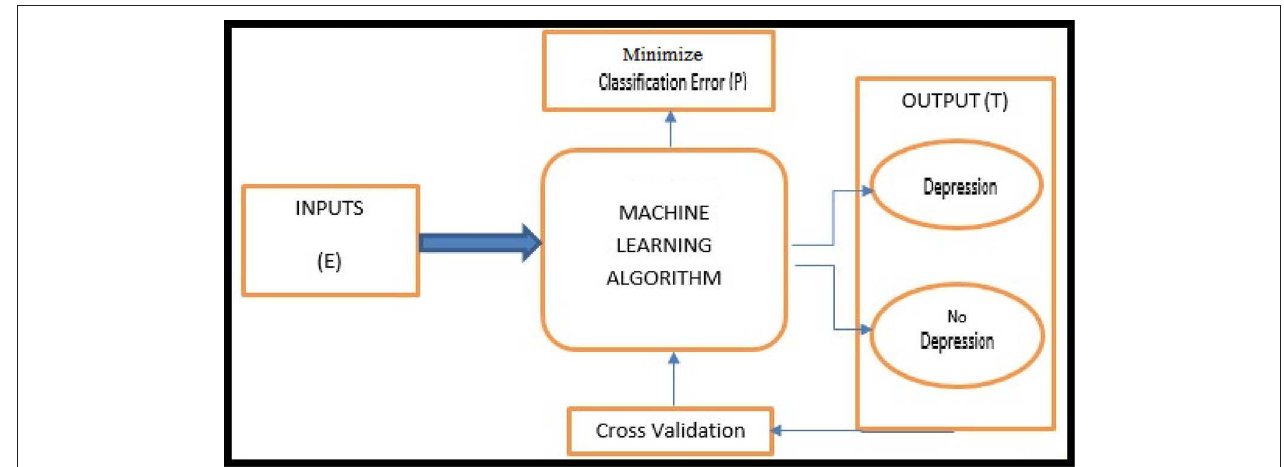
FIGURE 1 | The supervised machine learning model. Source: Authors’ own compilation.